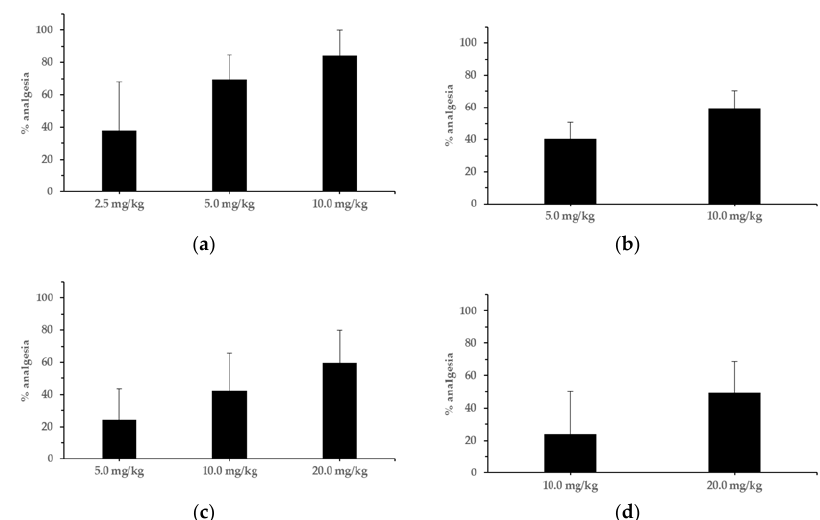
Figure 1. The analgesic potency of compound 6a and ralfinamide (n = 8). ( a ). The results of the dose-effect relationship assay of compound 6a . ( b ). The results of the oral administration assay of compound 6a . ( c ). The results of the dose-effect relationship assay of ralfinamide. ( d ). The results of the oral administration assay of ralfinamide.